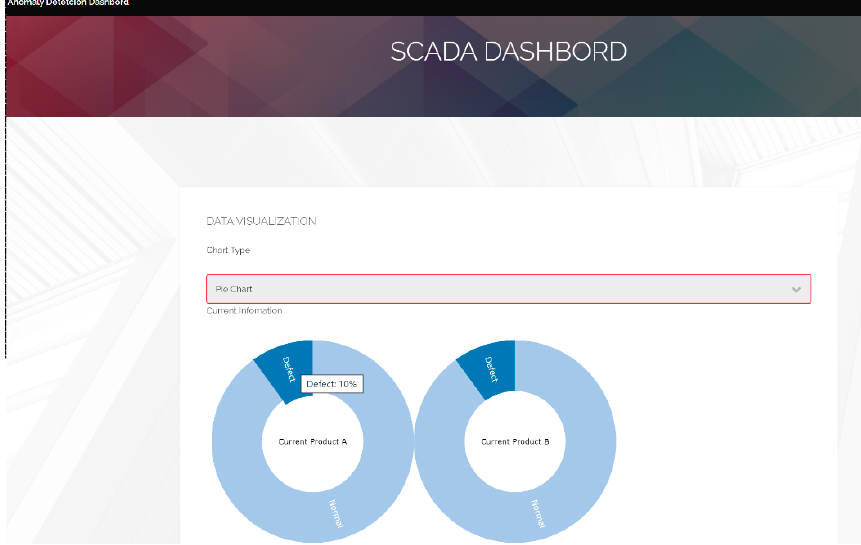
Figure 14. The real-time anomaly detection SCADA dashboard.